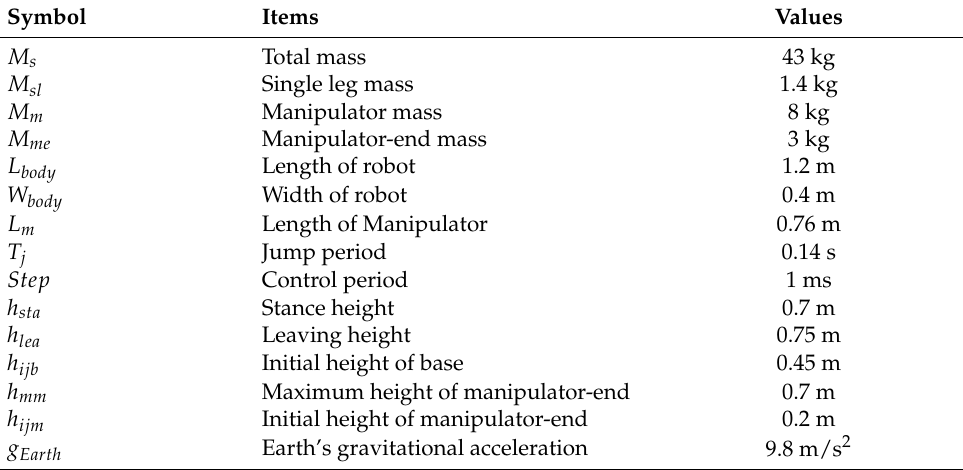
Table 2. Parameters for simulation and